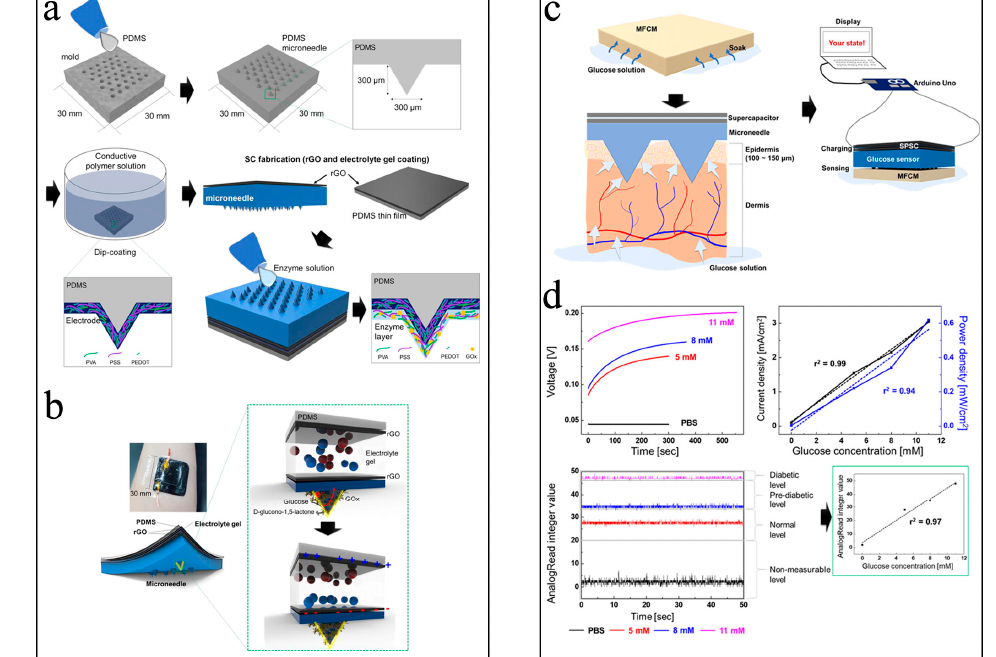
Figure 6. ( a ) Schematic diagram of the fabrication process of microneedle-type glucose sensor; ( b ) the sketch of composition of this microneedle-type glucose sensor; the working principle ( c ) and sensing performance tests of this glucose sensor ( d ) [47]. Copyright 2022 John Wiley and Sons.